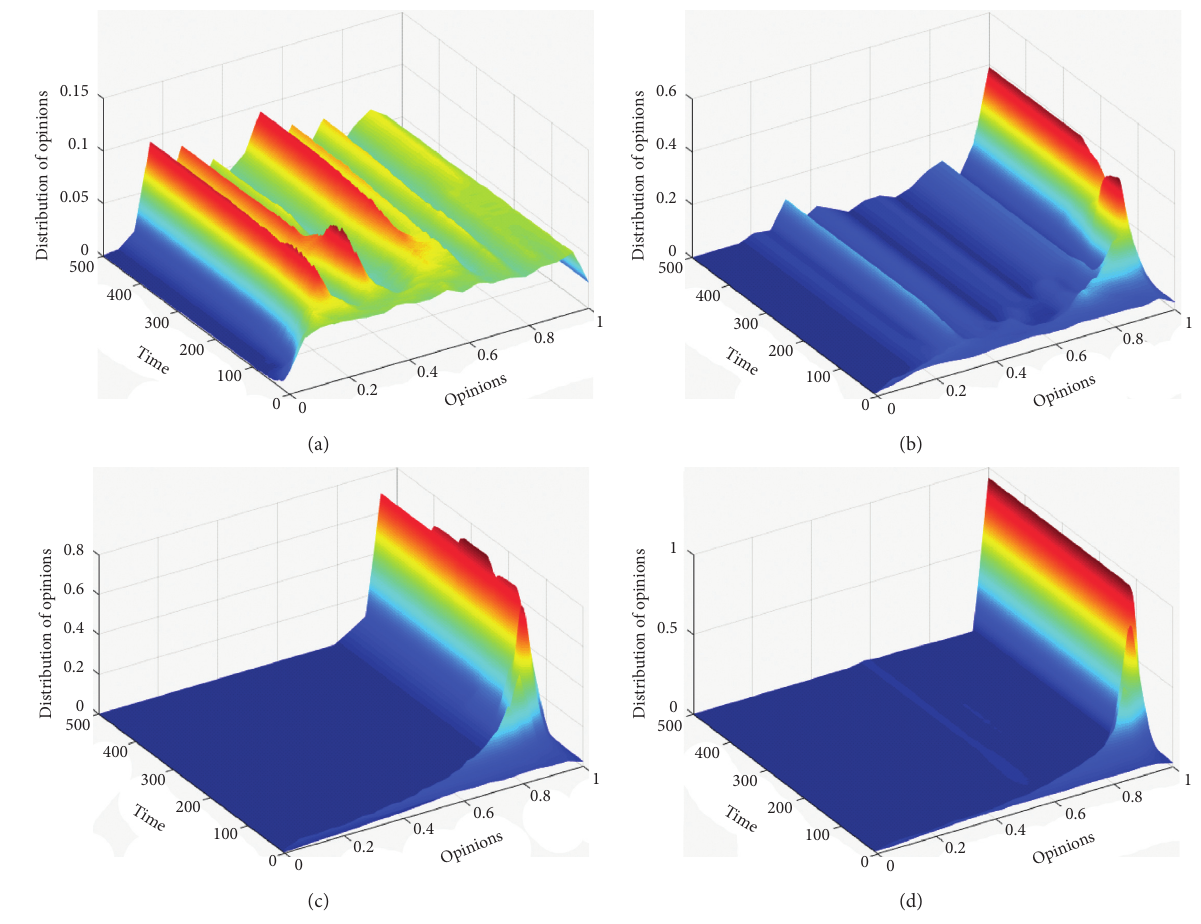
Figure 3: Group opinion distribution evolution when x � 1. Compared with the condition when x � 1/2, the value of d group polarization is formed under x � 1. (a) d m � 0 . 15. (b) d m � 0 . 3. (c) d m � 0 . 45. (d) d m � 0 .